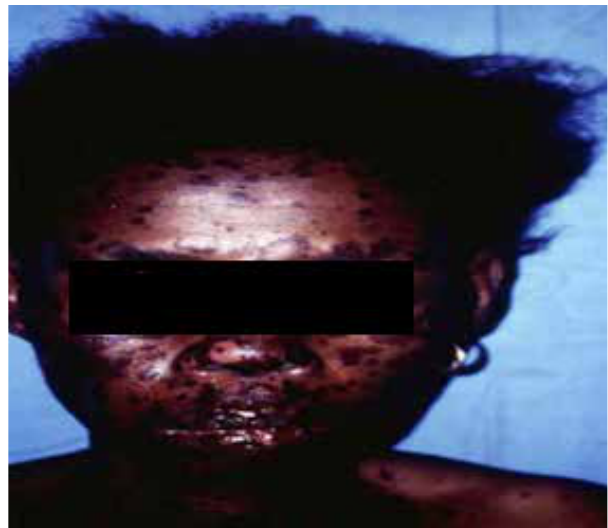
Figure 1: Stevens Johnson Syndrome (SJS): In a patient treated with Co-rimoxazole/Sulfamethoxazole